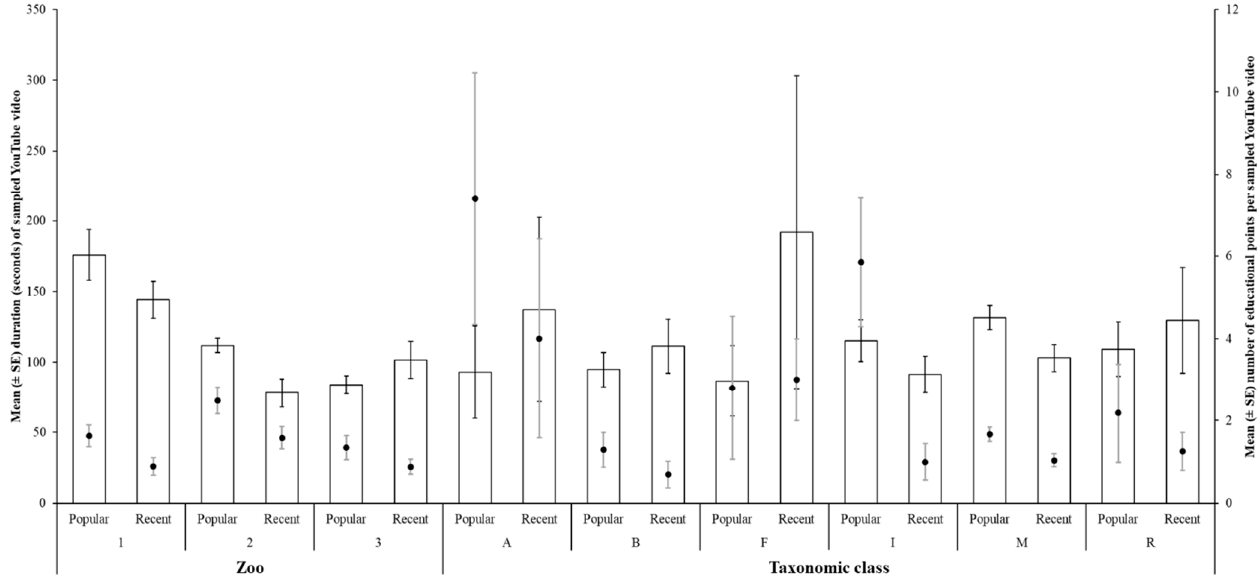
Figure 5. Duration and education, the mean duration of YouTube videos (left Y-axis) compared to the mean number of educational points per YouTube video (right Y-axis) for each zoo overall and for each taxonomic class posted about by these three zoos. Mean values ± standard error.